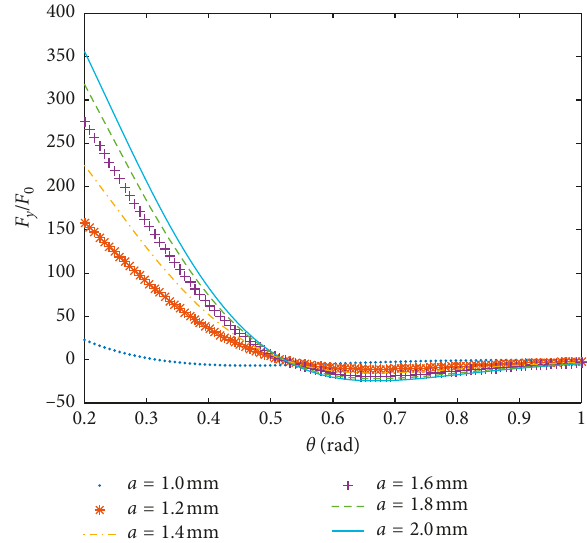
and angle θ for different 2 / c ( 2 ) . 44 44